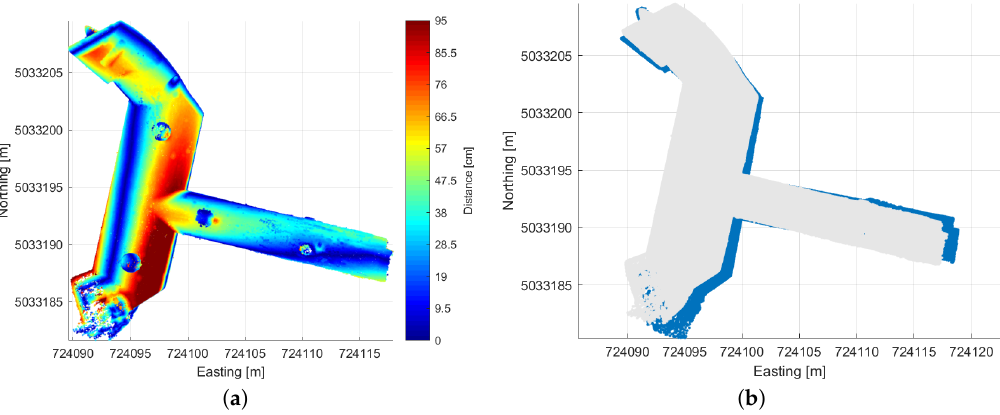
Figure 9. ( a ) Map of point-to-point distances between TLS and photogrammetric point clouds in the WGS84 UTM32 coordinate system. ( b ) Top view of the two georeferenced point clouds (TLS (blue) and the photogrammetric ones (gray)).